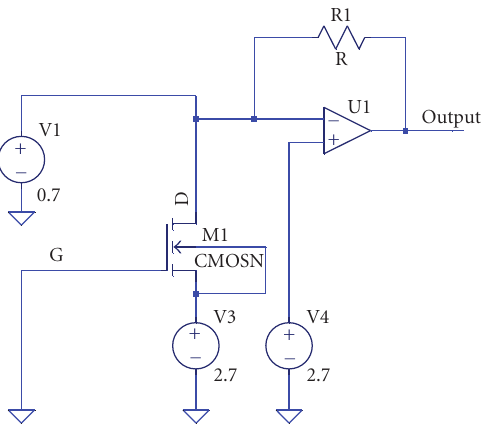
Figure 2: Neuron-FET transimpedance amplifier, as described in [9].